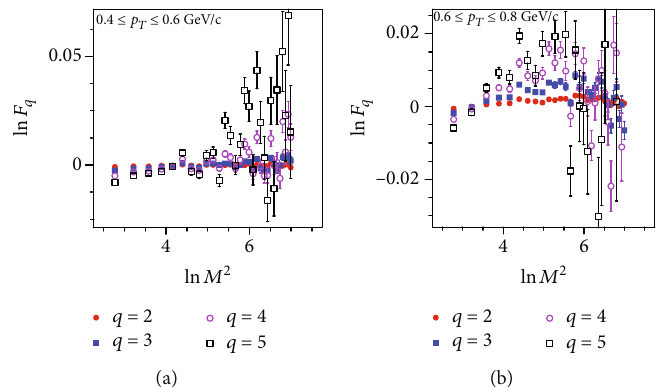
M 2 ) for EPOS3-hydro events for the p